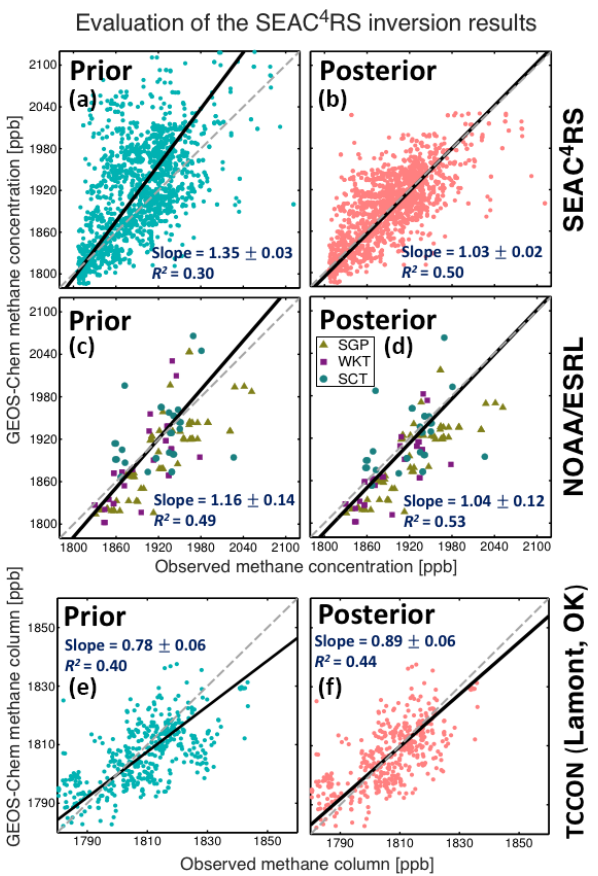
Figure 4. Evaluation of the SEAC 4 RS inversion of methane emis- sions in the Southeast US for the 6 August–21 September 2013 period. Panels (a, b) compare GEOS-Chem methane concentra- tions with the SEAC 4 RS observations, using prior emissions (left) and posterior emissions (right). Panels (c, d) compare GEOS- Chem methane concentrations with independent observations from the three NOAA / ESRL surface sites in the inversion domain (see Fig. 2 and caption). Panels (e, f) compare GEOS-Chem methane columns with TCCON hourly column observations at Lamont, Ok- lahoma (Wennberg et al., 2017), after correction for stratospheric bias in the model (Turner et al., 2015). The 1 : 1 lines (dashed) and the reduced-major-axis(black solid line) linear regressions are also shown, along with the coefficients of determination ( R 2 ) and the slopes ( ± 1 σ ) derived from the bootstrap method.